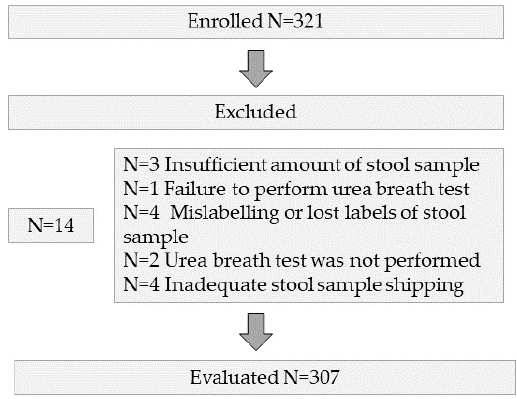
Figure 1. Flow diagram of the enrolled patients.